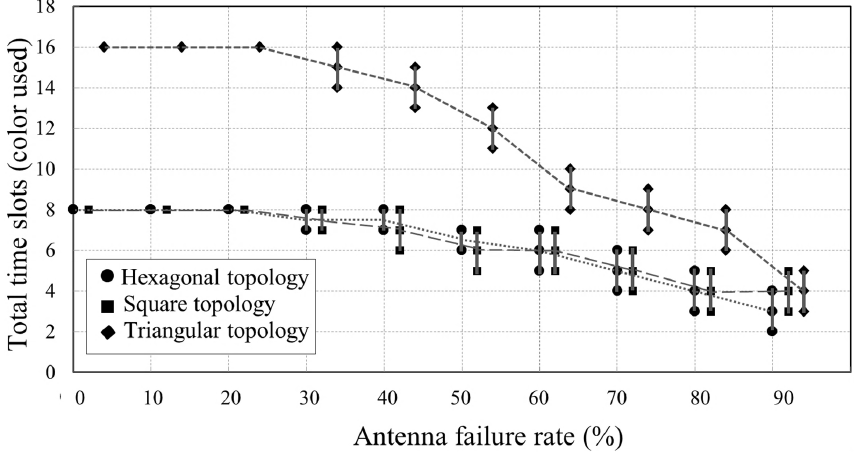
Figure 15. Simulation of the total time slots for arrays with different antenna failure